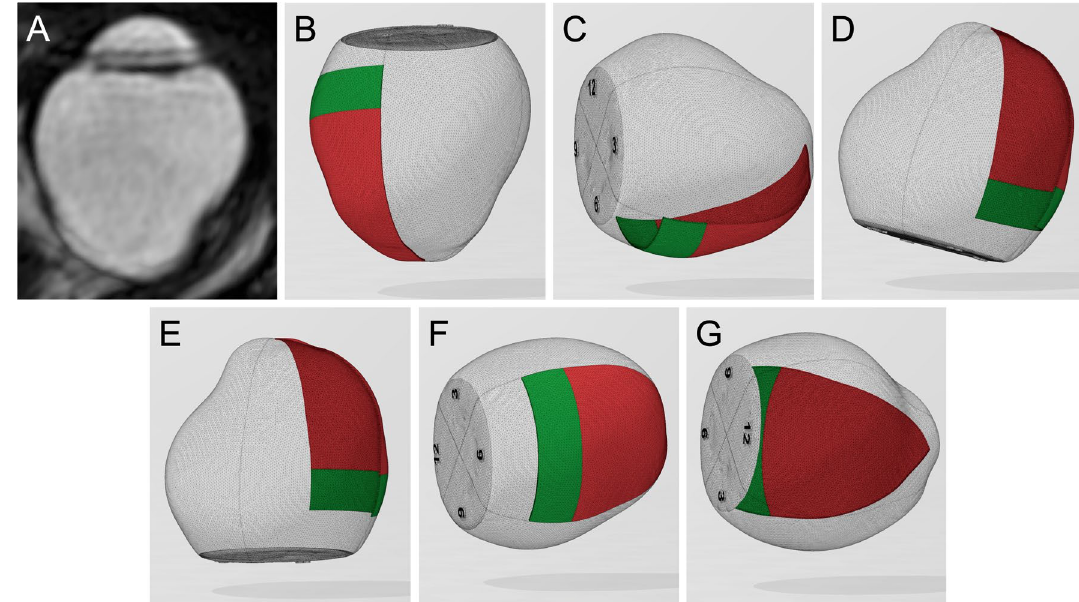
Figure 1. Directions of the three-dimensional vitreous cavity in case 1. ( A ) The real MRI image, ( B ) Supine, ( C ) sitting, ( D ) prone with closed eyes, ( E ) prone, ( F ) lower temporal, and ( G ) lower nasal positions. The inferior- anterior and inferior-posterior retina are colored green and